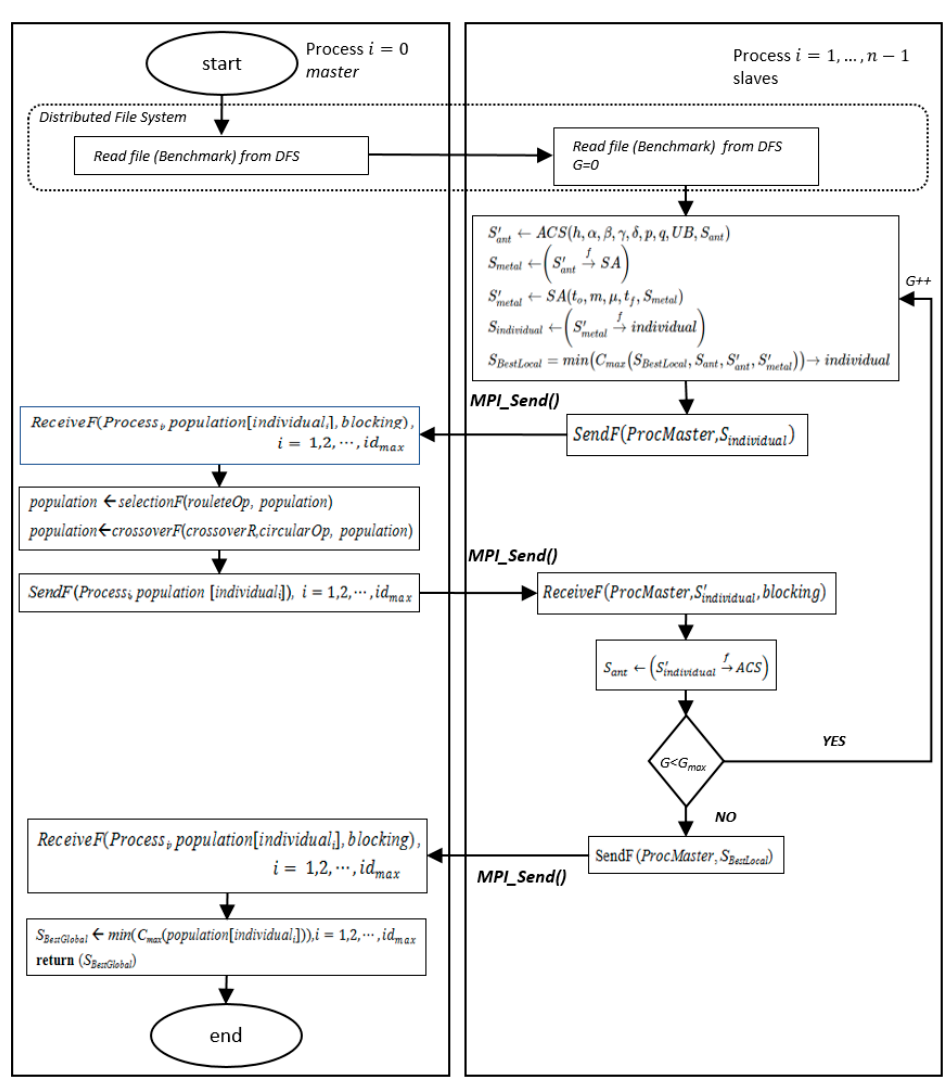
Figure 7. Hybrid genetic algorithm in grid environment (HGAG).